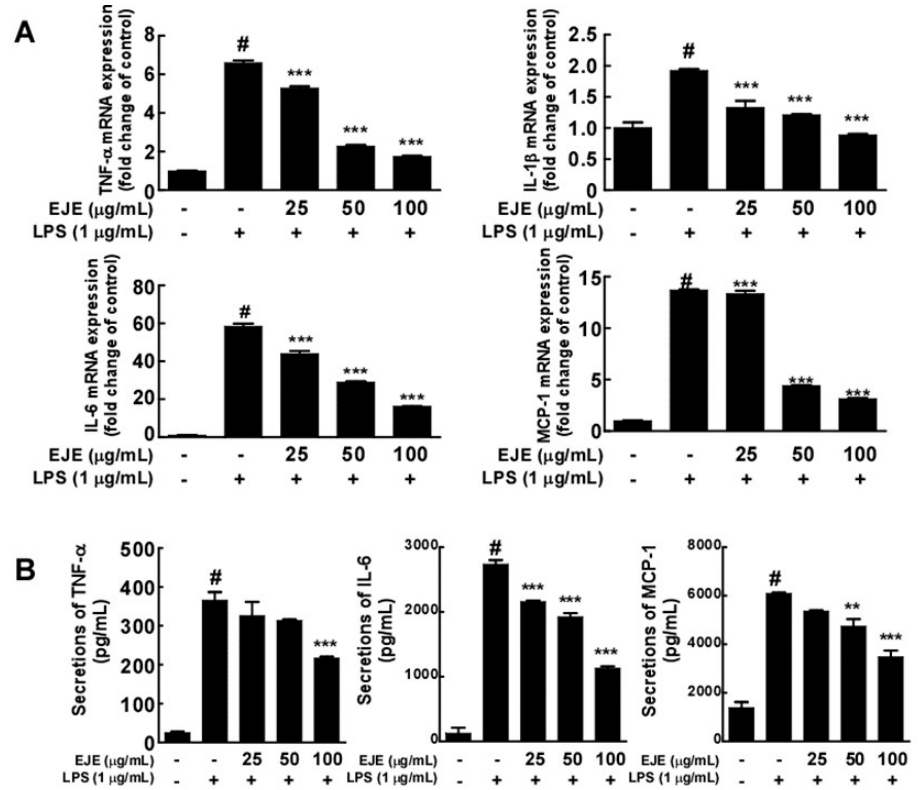
Figure 2. E ff ect of EJE on LPS-induced mRNA and protein expression of pro-inflammatory cytokines Figure 2. Effect of EJE on LPS ‐ induced mRNA and protein expression of pro ‐ inflammatory cytokines in in BV2 cells. ( A ) EJE inhibited LPS-induced TNF- α , IL-1 β , IL-6 , and MCP-1 mRNA expression in BV2 BV2 cells. (A) EJE inhibited LPS ‐ induced TNF ‐α , IL ‐ 1 β , IL ‐ 6, and MCP ‐ 1 mRNA expression in BV2 cells. cells. The production of TNF- α , IL-1 β , IL-6 , and MCP-1 mRNA was analyzed by quantitative real-time The production of TNF ‐α , IL ‐ 1 β , IL ‐ 6, and MCP ‐ 1 mRNA was analyzed by quantitative real ‐ time RT ‐ RT-PCR, as described in Materials and Methods. ( B ) EJE inhibited LPS-induced secretion of TNF- α , IL-6 and MCP-1 in BV2 microglial cells. The secretion of TNF- α , IL-6, and MCP-1 was quantified using ELISA kits, as described in Materials and Methods. Hash symbols (#) indicate a significant di ff erence ( p < 0.001) between the control group and the group exposed to LPS alone; asterisks (** and ***) indicate significant di ff erences ( p < 0.01 and p < 0.001 respectively) between groups co-treated with LPS and EJE and the group exposed to LPS alone. In this and all the following Figures, data are presented as the mean ± SEM of three independent